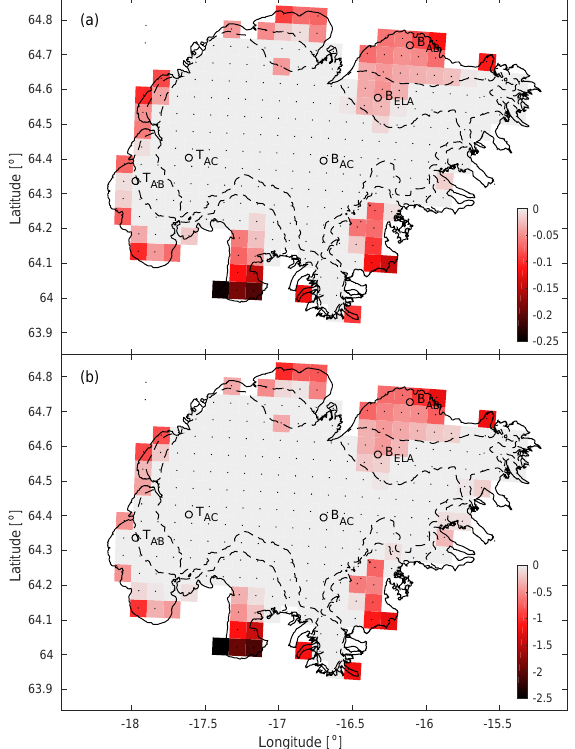
Figure 12. Difference in (a) mean albedo and (b) mean SMB in mw.e. for the period 2001–2014 between two runs with HIRHAM5, one using a MODIS bare ice albedo map and the other with a con- stant ice albedo. The locations of the AWS stations used in this study are shown with black